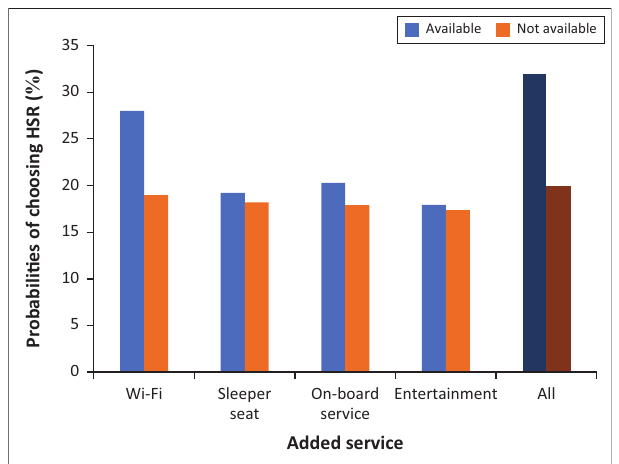
FIGURE 8: Probability of choosing high-speed rail based on amenity options.